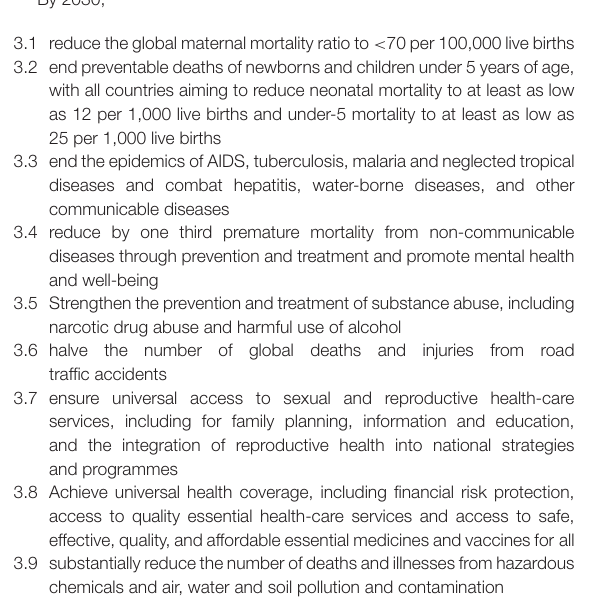
BOX 2 | Goal 3: Good health and well-being (United Nations, 2015). Targets: By